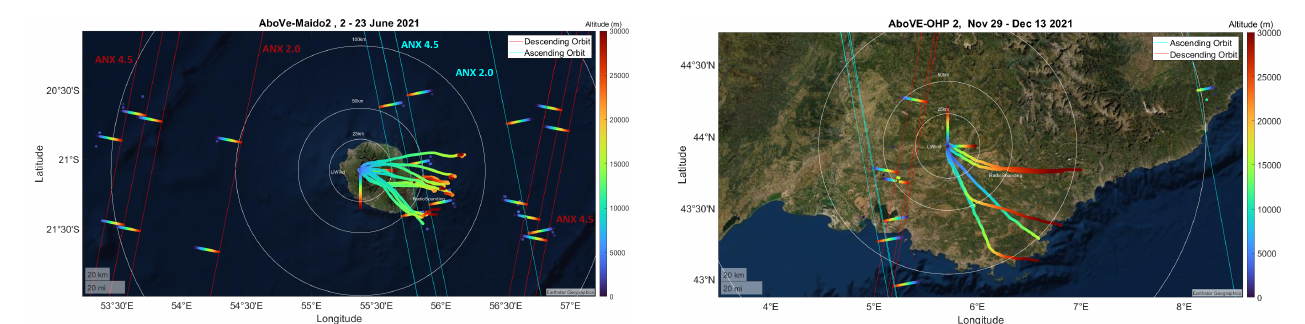
Figure 1. AboVE-Maido-2 campaign overview with ascending and descending Aeolus overpasses in cyan and red. The colored trajec- tories represent the ascending phase of the radiosondes, with their altitude shown through a color map. The straight colored strokes represent lidar measurements from Aeolus and the ground-based li- dar. The ascending node crossing configuration is specified for each Aeolus overpass. Credit: base map source is Earthstar Geographics.